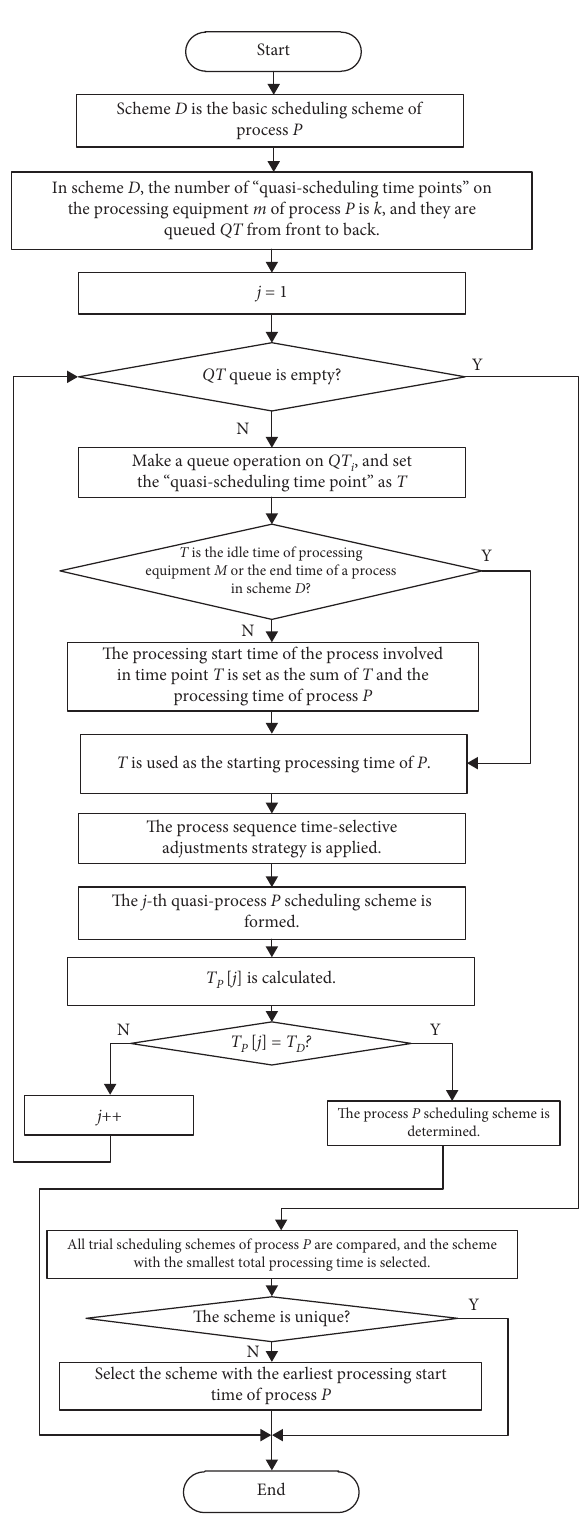
Figure 1: The flowchart of the process sequence time-selective scheduling